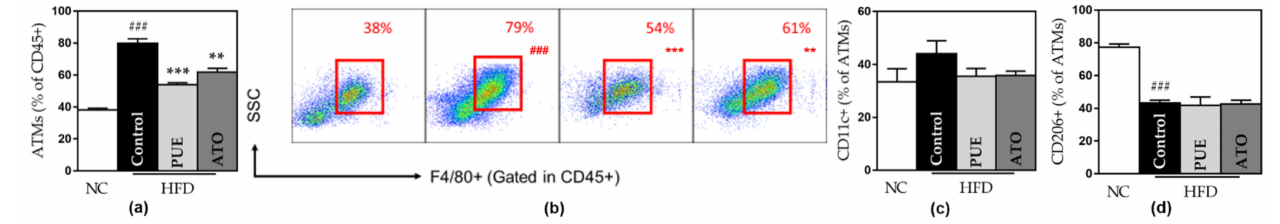
Figure 5. ATM populations. ( a ) CD45 + ATMs. ( b ) Flow cytometry result of CD45 + ATMs. ( c ) CD11c + ATMs, and ( d ) CD206 + ATMs. Data represent mean ± standard error of the mean